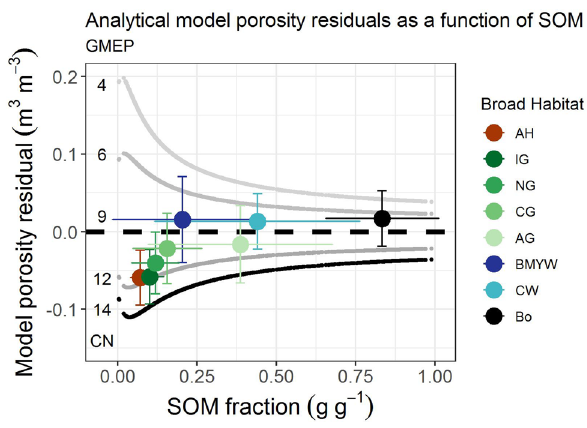
Figure 5. Sensitivity plot for the porosity residuals for the main broad habitats from the model (Eq. (7), black line plotted in Fig. 3D, CN = coordination number) assuming, intrinsic particle densities ρs OM = 1.4 g cm −3 and ρs M = 2.7 g cm −3 and values for the ‘pure’ SOM BD (ρ OM = 0.09 g cm −3 ) and mineral BD (ρ M = 1.94 g cm −3 ) vs SOM. The upper and lower curved lines are the approximate bounds. The solid circle markers represent the mean response by habitat type (Fig. 4 caption) with standard deviation error bars. The highly managed arable (red) and improved grassland (dark green) show the largest deviation from the